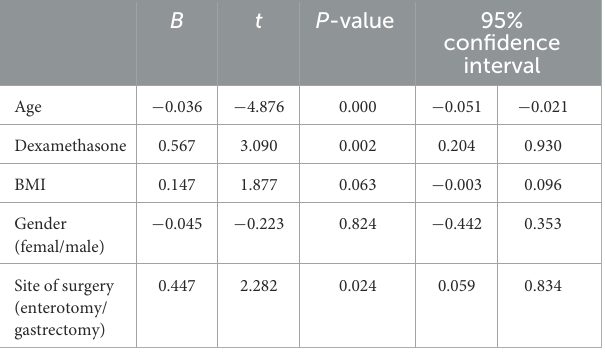
TABLE 5 Factors that may influence caloric intake from enteral nutrition.